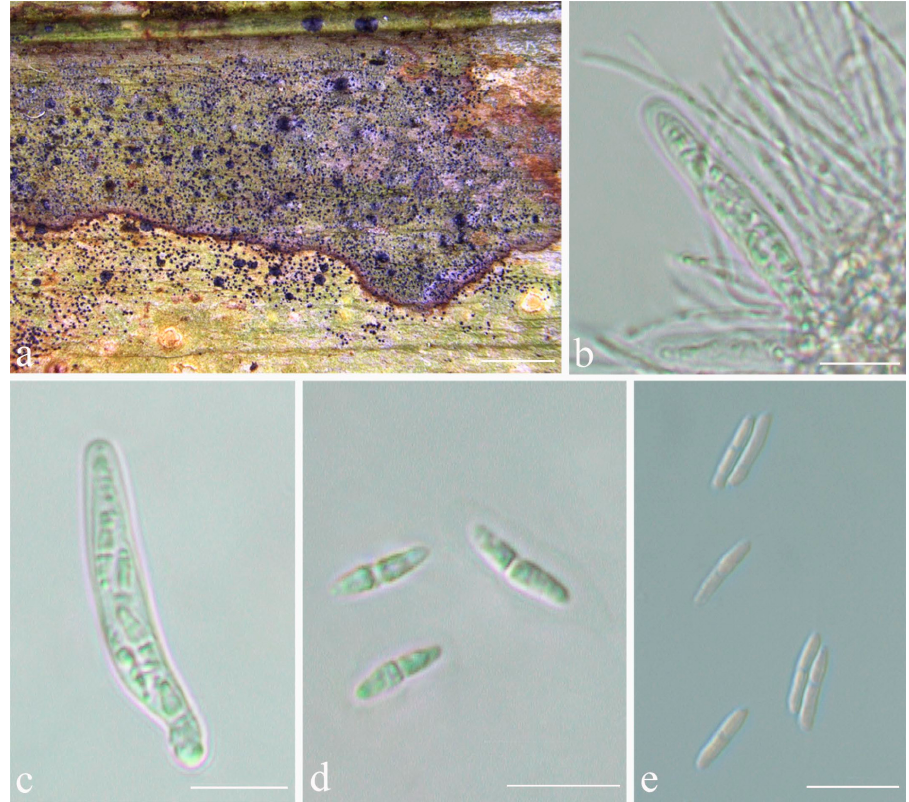
Figure 4. Phylloporis palmae (epitype, ISE–33670). ( a ) Thallus; ( b ), ( c ) asci; ( d ) ascospores; ( e ) mac ‐ roconidia. Scale bars: ( a ) = 2 mm; ( b – e ) = 10 μ